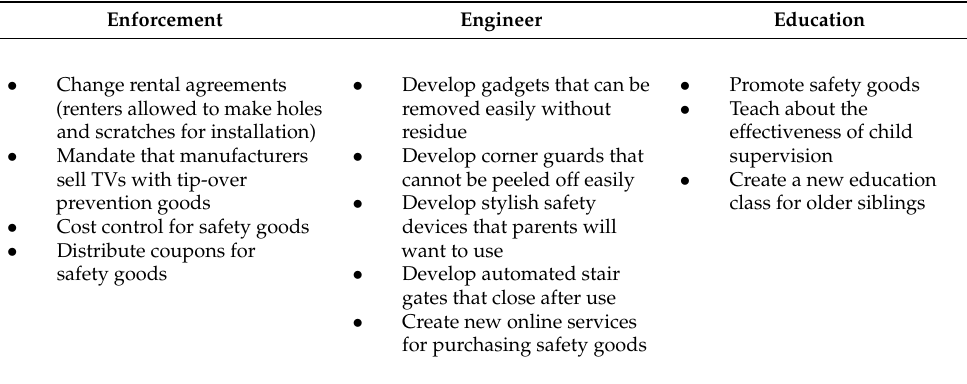
Table 3. Summary of possible strategies based on the survey